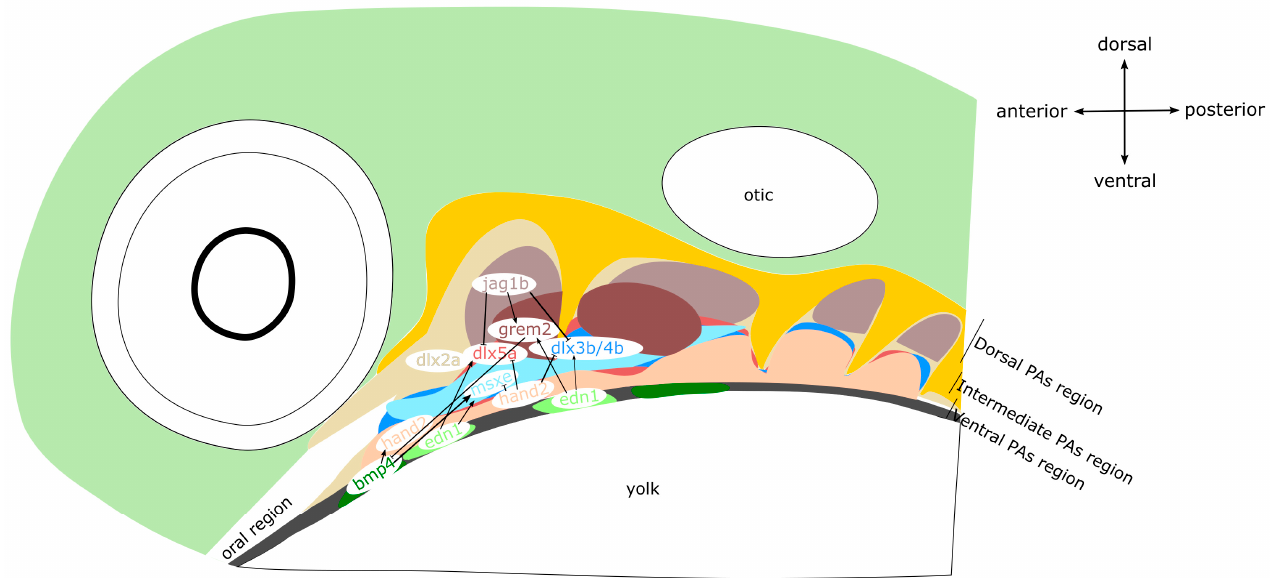
Figure 2. Schematic model of PA patterning along the dorsal–ventral axis in zebrafish at 30–36 hpf (hours post-fertilization). Lateral view, head to the left, pharyngeal endoderm in dark yellow, pharyngeal ectoderm in dark grey. The dorsal region of PAs is established by co-operative action of jag1b and grem2 and characterized by the expression of dlx2a . The intermediate region of PAs is controlled by dlx3b/4b/5a and msxe, which are downregulated by edn1 in the pharyngeal ectoderm. The ventral region of PAs is dominated by the expression of bmp4-hand2 . The craniofacial phenotypes of edn1 and hand2 mutants appear to be similar. Hand2 zebrafish mutants lack the lower jaw and ventral set of second pharyngeal cartilages [129]. In fact, edn1 positively regulates hand2 during the development of ventral pharyngeal car- tilages. Upon the early NC migration, hand2 restricts cell proliferation during the anterior- ventral protrusion of NCCs, which is under the control of edn1 . However, at later stages of development, the function of hand2 shifts, and it eventually promotes the cell prolifer- ation [131]. Additionally, hand2 also influences the cell movement within the mandibular arch, but apparently independently of edn1 [131]. Nkx3.2 is expressed in ectomesenchyme of the lower jaw primordium, and during the chondrification, its expression becomes lo- calized within and around the jaw joint. In keeping with this, hand2 regulates develop- ment of the jaw joint via modulation of nkx3 . 2 expression [129,132]. Therefore, n kx3.2 is involved in specification of the intermediate region of PAs, the hinge region, and is ex- pressed ventrally to dlx2a and dorsally to hand2 [129]. The expression of nkx3.2 in the pre- sumptive jaw hinge region is regulated by Hand2 via gsc and dlx3b/4b/5a. Hand2 activates the expression of gsc , which in turn represses nkx3.2 . Meanwhile, dlx3b/4b/5a repress gsc and activate nkx3.2 [132]. Dlx genes are under the control of Edn1 and Bmp signalling [133]. The genome of zebrafish contains four bigene dlx pairs— dlx1a / dlx2a , dlx3b / dlx4b , dlx5a / dlx6a , and dlx2b / dlx4a [134]. Along the dorsoventral axis of PAs, dlx3b / dlx4b and dlx4a can be detected in the intermediate region. While dlx2a is expressed in the dorsal region of PAs, dlx5a / dlx6a are found in the ventral region and the intermediate region of PAs (see Figure 2). The